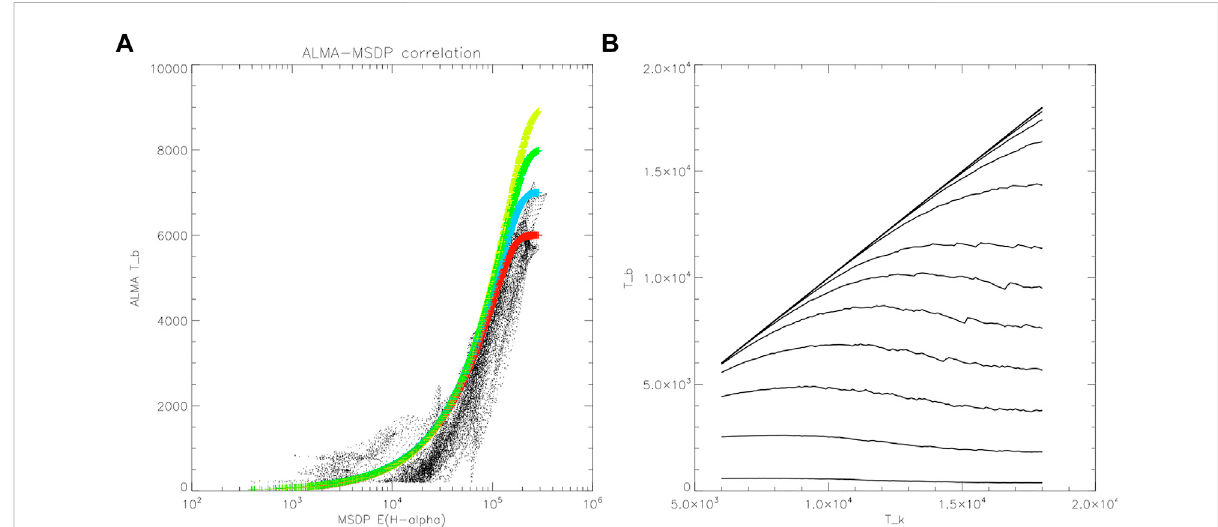
FIGURE 6 (A) -relationbetweenobserved T b and E (H α )inunitsoferg s − 1 cm − 2 sr − 1 forallpixelsfromFigure5(dots).Colorcurvesindicatethesamerelation constructed from non-LTE models and assuming a uniform distribution of kinetic temperature in the whole FOV (yellow - 9000 K, green - 8000 K, blue-7000 K, red-6000 K). (B) -theoreticalvariations ofBand3brightness temperature T b versus 1D-slabkinetic temperature T k forseveralvalues of the H α line integrated intensity. This plot was constructed from the used grid of models (small kinks on some curves are due to fi nite separation between themodelsinthegrid).Theindividual curvescorrespond(from below) to E (H α )from10 4 up to10 6 erg cm − 2 s − 1 sr − 1 . Reproduced from Heinzel et al.